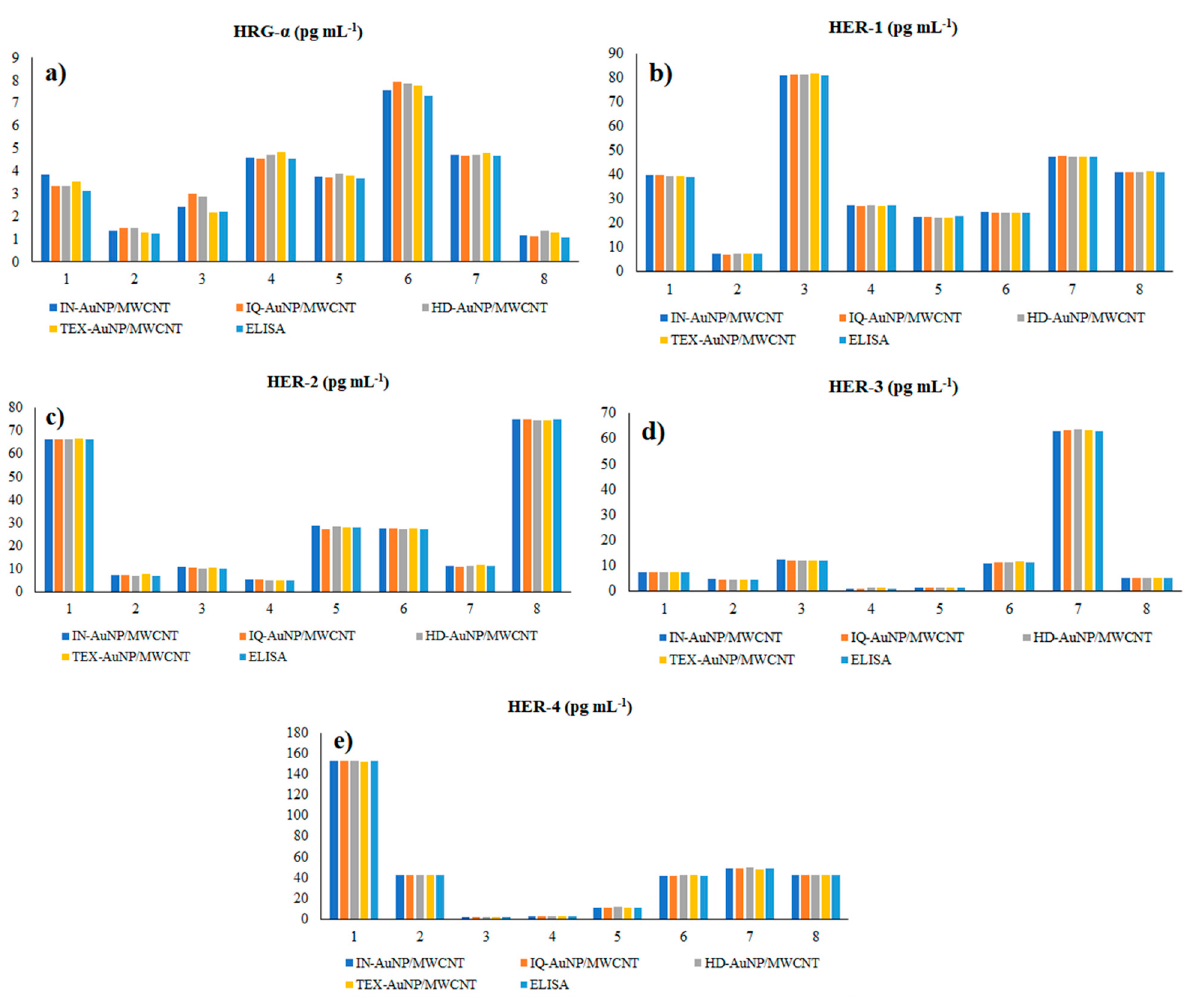
Figure 4. Determination of HRG- α ( a ), HER-1 ( b ), HER-2 ( c ), HER-3 ( d ), and HER-4 ( e ) in brain tumor tissue samples, using 3D stochastic microsensors based on IN/AuNP-MWCNT, IQ/AuNP-MWCNT, HD/AuNP-MWCNT, and TEX/AuNP-MWCN, and the gold standard method-ELISA. Paired t-tests were performed at 99.00% confidence level (tabulated theoretical t-value: 4.032) for the assay of HRG- α , HER-1, HER-2, HER-3, and HER-4 in whole blood and